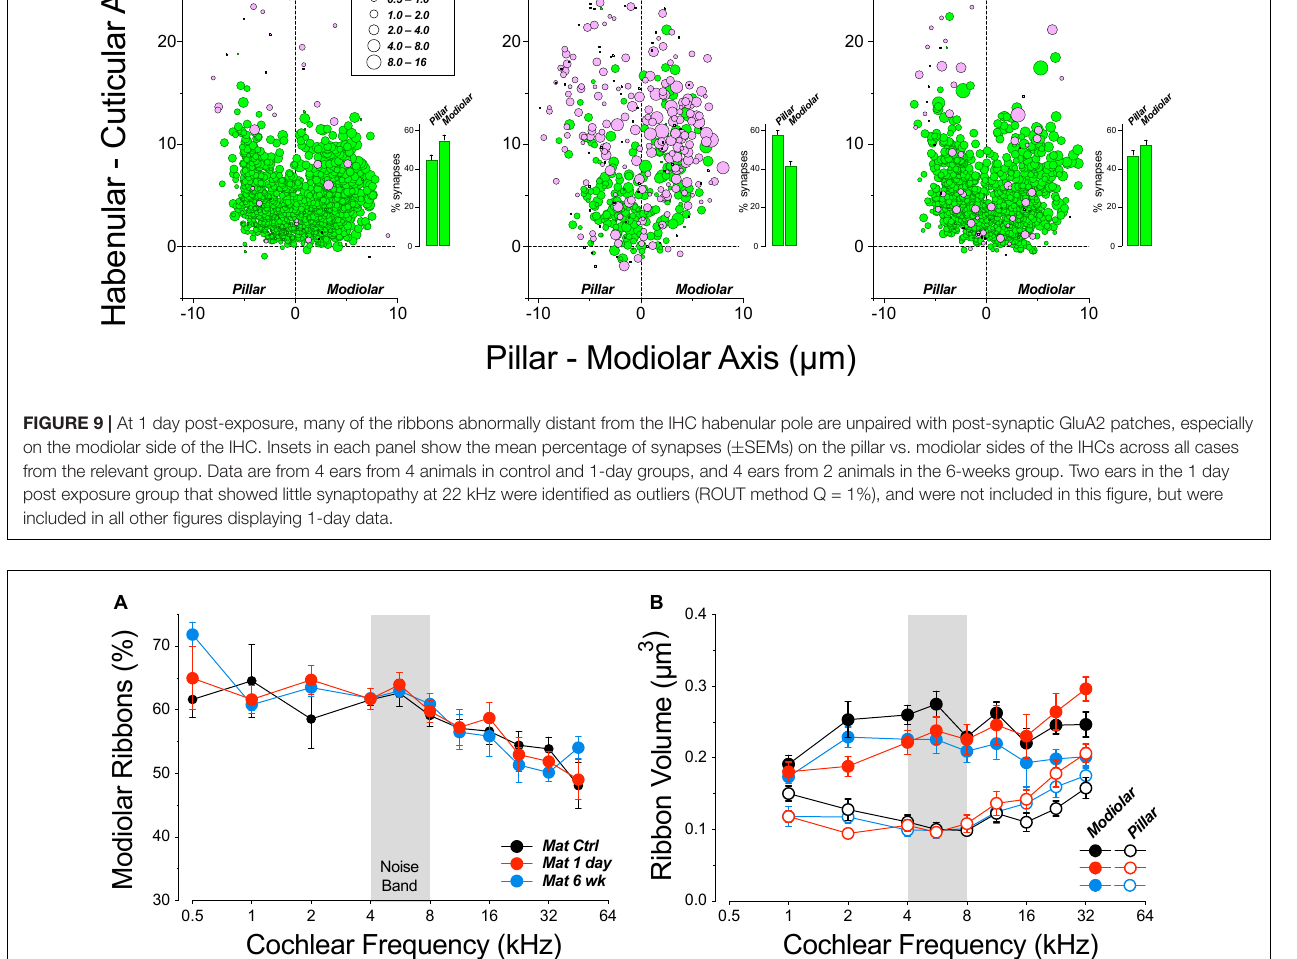
synapses is incomplete at 6 weeks. At 1 day post exposure, ribbons show a frequency-dependent size reduction (apex) and elevation (base) on both sides of the IHCs ( Figure 10B , frequency × group p ≤